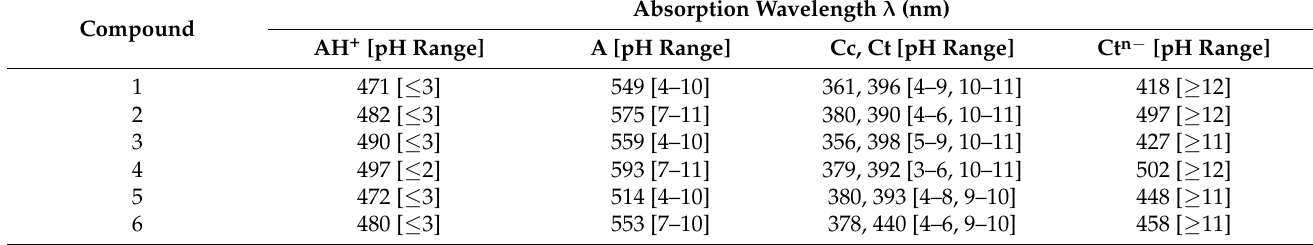
Table 6. Absorption wavelengths of the predominant species of the flavylium dye solutions at different pH values.